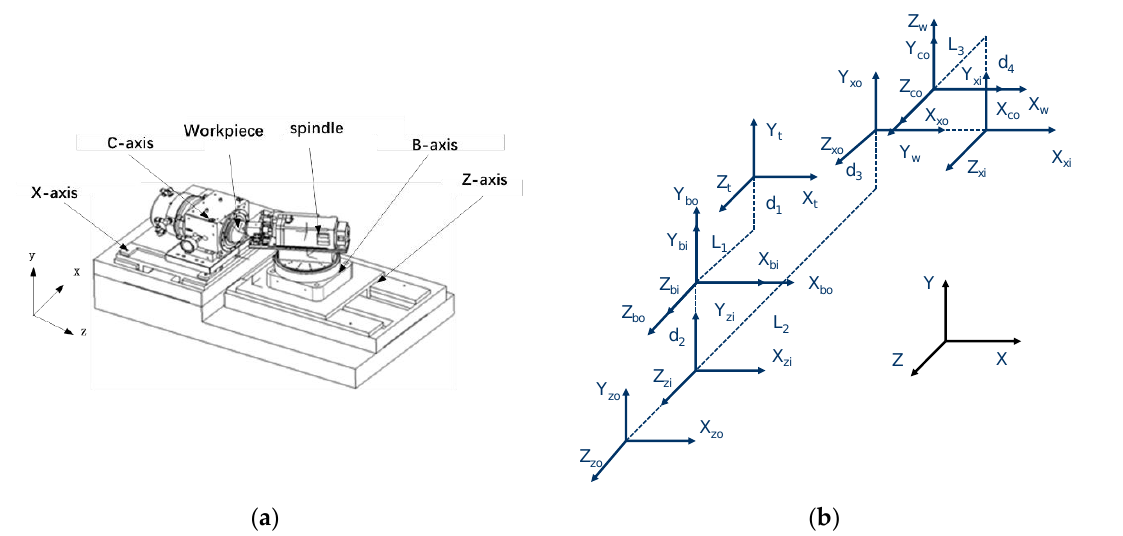
Figure 2. Structural diagram of the four − axis machine tool. ( a ) The structure model of the four − axis machine tool. ( b ) The coordinate system of kinematic structure of the four − axis machine tool.